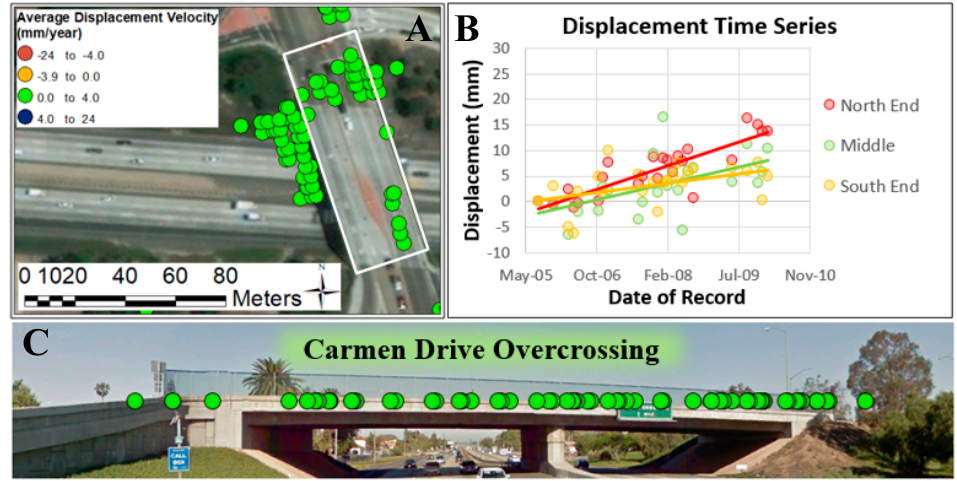
Figure 10. Carmen Drive overcrossing displacement model. ( A ) Aerial view of the bridge; ( B ) Displacement time series; ( C ) Elevation view of the bridge. Source: Images for Figure 10A,C were obtained from Google Earth [48].